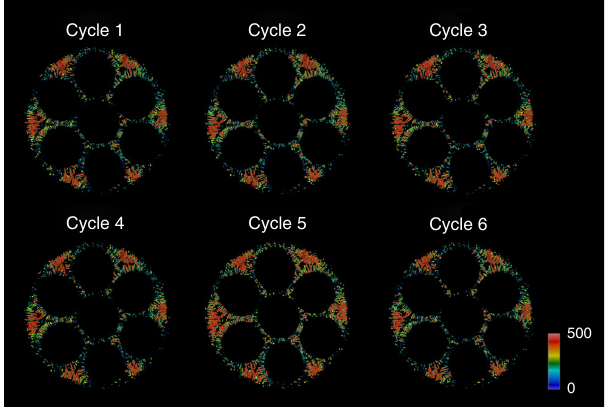
Fig. 6 Volume rendering of pores during the thermal cycling of the solid oxide fuel cell. All micro-CT volume were aligned, then the pores were segmented and labelled according to their volume. The colour bar axes values have been chosen to enhance the contrast and make also the small pores in the microchannels visible (colour bar axes in arbitrary units)